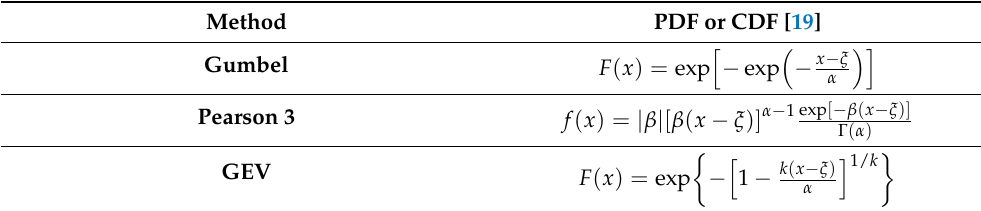
Table 2. The PDF or CDF formulas used for the frequency